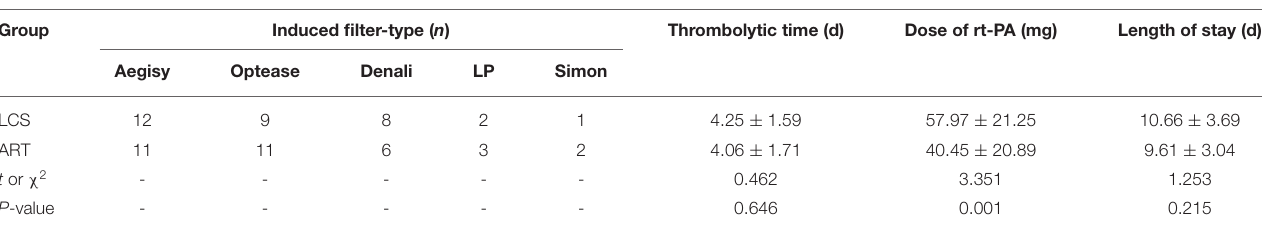
TABLE 2 | Treatment of